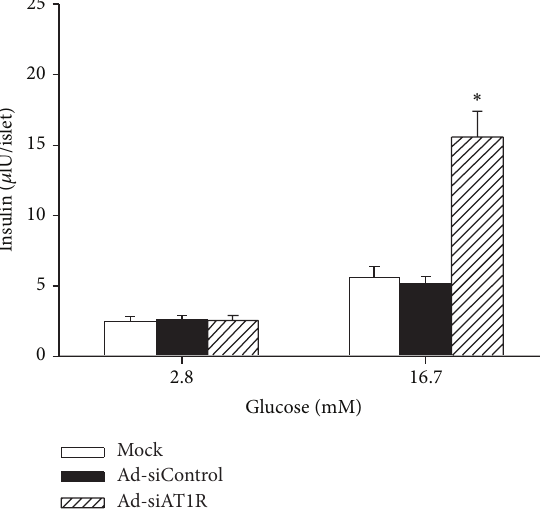
Figure 5: Effect of AT1R silencing on insulin secretion in islets. Islets were treated with Ad-siAT1R, Ad-siControl, or Mock, and 72 h later, insulin secretion was measured at basal and stimulatory glucose. Results are represented as mean ± SD for six independent experiments. ∗ 𝑃 < 0.05 versus